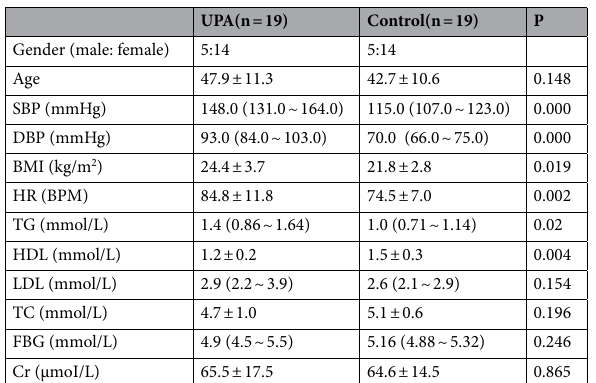
Table 1. Baseline clinical characteristics of the study cohort. SBP: systolic blood pressure; DBP: diastolic blood pressure; BMI: body mass index; HR: heart rate; TG: triglyceride; HDL: high density lipoprotein; LDL: low density lipoprotein; TC: total cholesterol; FBG: fasting blood glucose; Cr: creatinine. P < 0.05 was considered significant.